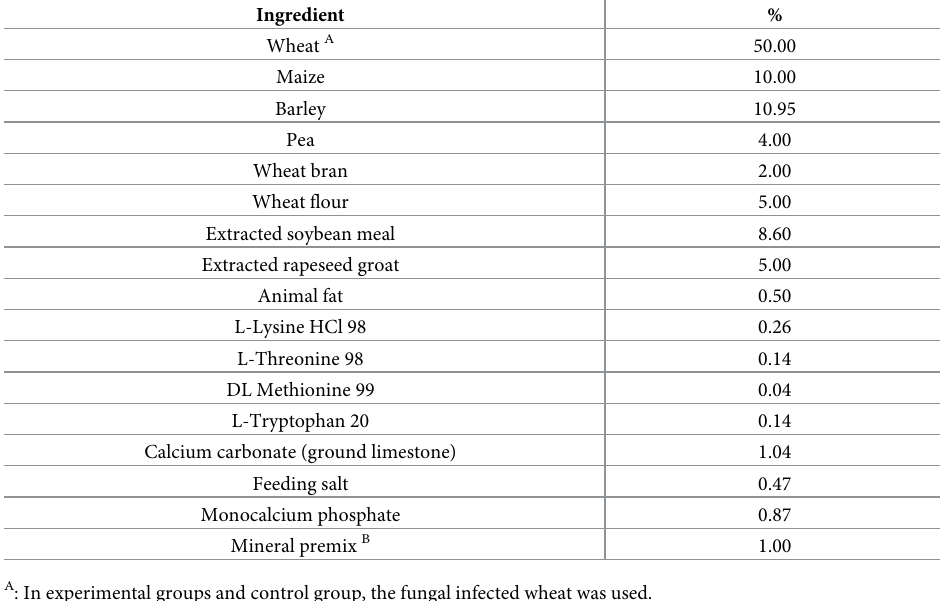
Table 1. Ingredient composition of the experimental diet for pigs